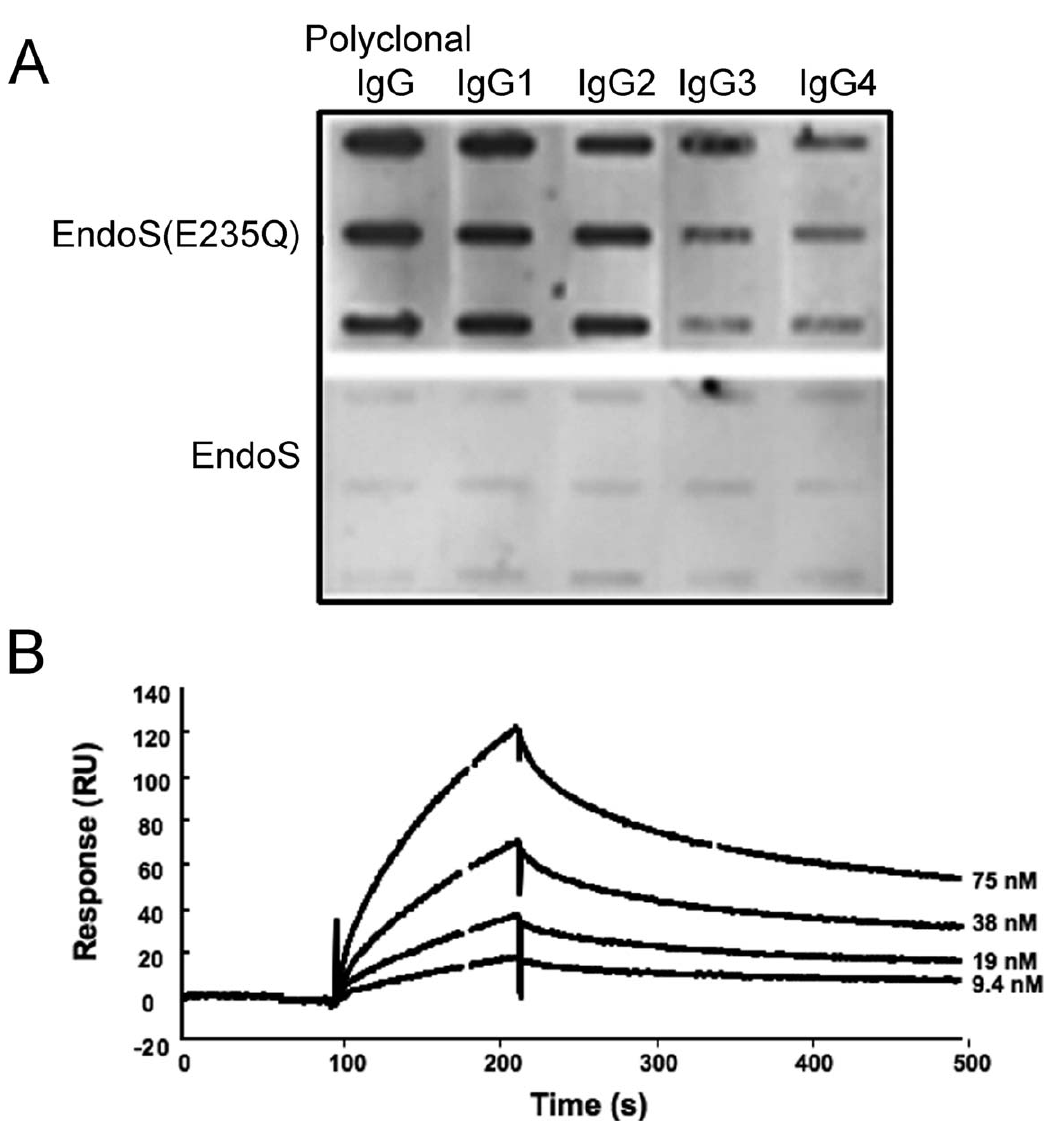
Figure 3. EndoS(E235Q) binds to all IgG-subclasses. Panel A . Slot-blot representing the binding of EndoS and EndoS (E235Q) to each IgG subclass immobilized onto a nitrocellulose membrane in amounts: 3, 1.5 and 0.75 m g. The binding was detected using antiserum against EndoS. Panel B . Binding of EndoS (E235Q) to immobilized IgG-classes using BIAcore technology. The selected plot shows EndoS (E235Q) binding to IgG1 using hydrolysed IgG1 as a reference (bulk changes subtracted).